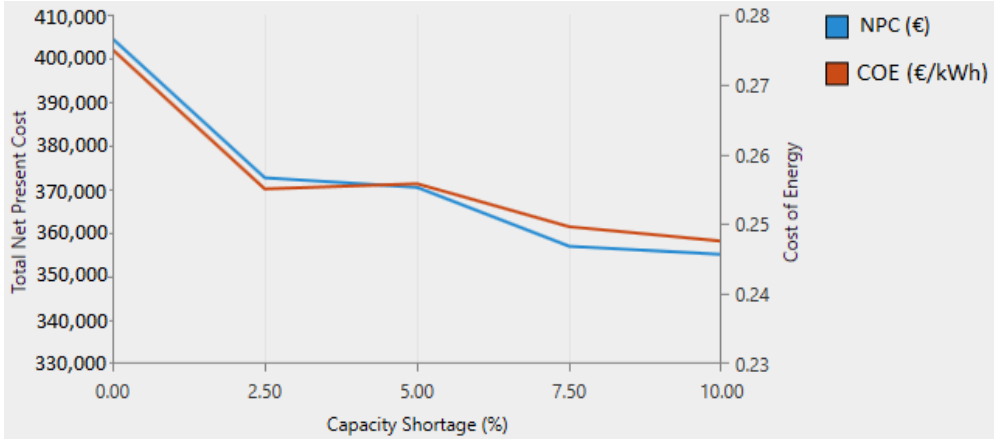
Figure 21. Sensitivity analysis result of the maximum capacity shortage.